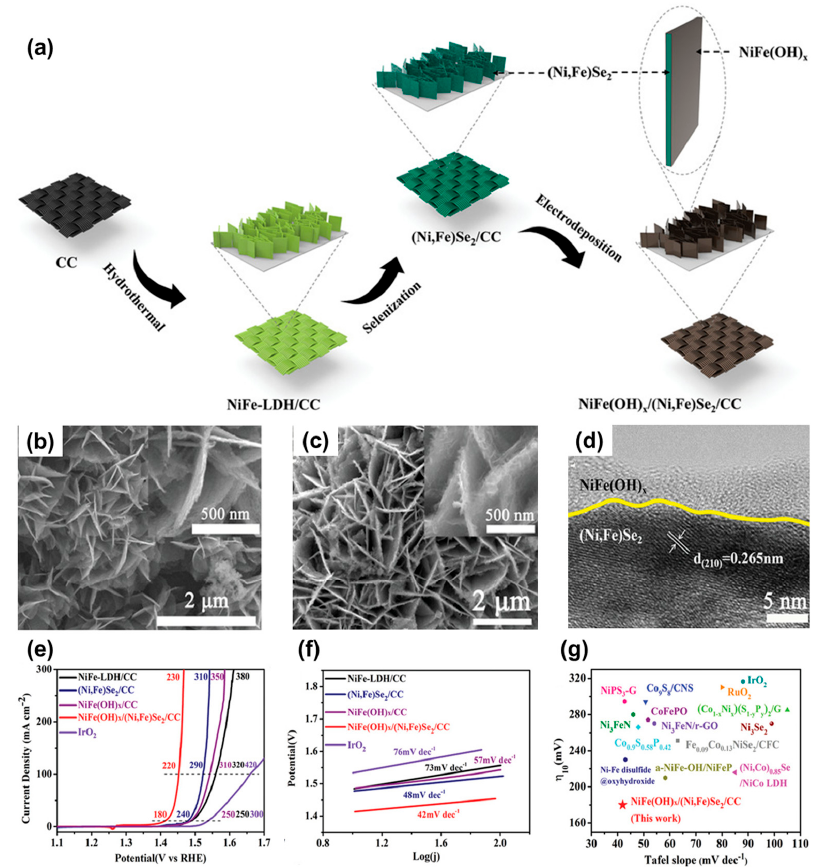
Figure 9. ( a ) Schematic illustration of the synthesis of NiFe(OH) x /(Ni, Fe)Se 2 on carbon cloth. SEM images of ( b ) (Ni, Fe)Se 2 /CC, ( c ) NiFe(OH) x /(Ni, Fe)Se 2 /CC, and ( d ) HRTEM images of NiFe(OH)x/(Ni, Fe)Se 2 /CC. ( e ) LSV curves and ( f ) Tafel plots of IrO 2 /CC, NiFe-LDH/CC, (Ni, Fe)Se